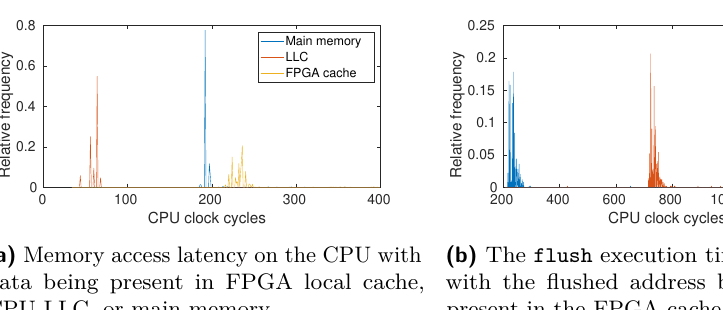
Figure 14: Memory access and flush execution latency measured from a Broadwell CPU with integrated Arria 10